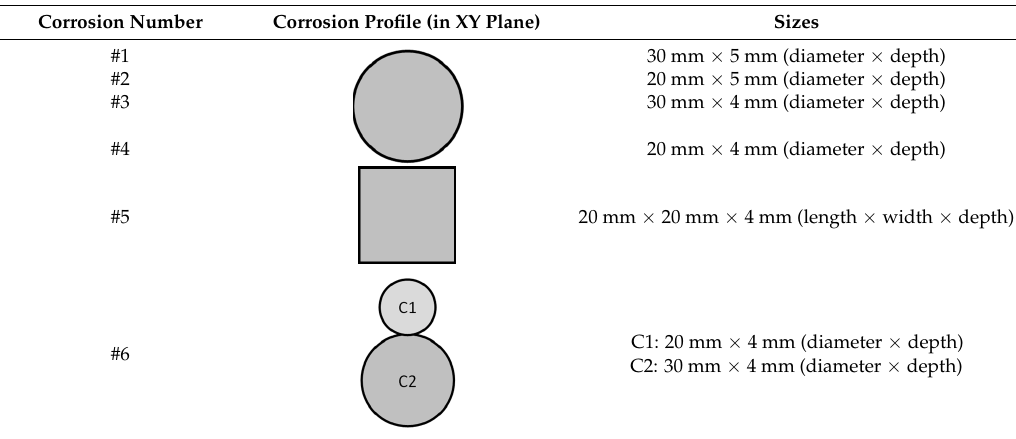
Table 3. Profiles and sizes of subsurface